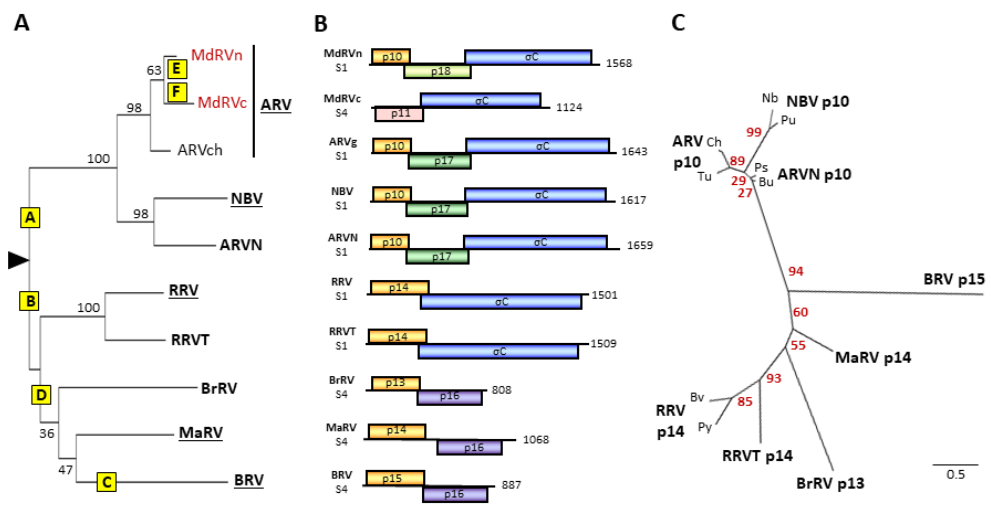
Figure 3. Phylogenetic analysis of fusogenic orthoreoviruses and FAST proteins and comparisons of their polycistronic genome segments. ( A ) Maximum likelihood unrooted phylogram of the sigma-class outer capsid clamp proteins of the eight fusogenic orthoreovirus species. The tree with the highest log likelihood is shown and included 10 amino acid sequences. See Supplementary Table S2 for a list of viruses, host species, and accession numbers The ARV species included single isolates from three subgroups, chickens (ARVch) and classical (MdRVc) and novel (MdRVn) MdRVs. Bootstrap values (500 replicates) indicating the percentage of trees in which the associated taxa clustered together are shown next to the branches. Branch lengths are to scale and measured by the number of substitutions per site. Yellow boxes labeled A–F indicate predicted genetic events leading to the extant species, as described in the text: A—recombinant gain of p10 FAST protein precursor; B—recombinant gain of p13/p14 precursor; C—potential recombinant gain of p15 precursor; D—recombinant gain of p16 and loss of fiber proteins; E—point mutations ablate p10 function; F—recombinant loss of p10 FAST protein. ( B ) Diagrams of the polycistronic S1 and S4 genome segments, drawn to approximate scale, of the indicated eight species or proposed species of fusogenic orthoreoviruses, plus the MdRVc (MdC) and MdRVn (MdN) subgroups of non-fusogenic ARVs from waterfowl. Open reading frames are depicted by rectangles, labeled to indicate the protein product and color-coded to depict functional or evolutionary protein relationships: yellow—FAST protein; blue—fiber protein; green—potential cell cycle inhibitory protein; purple—homologous proteins with no defined function; pink—heterologous nonfusogenic protein of no defined function. Numbers refer to mRNA length. ( C ) Maximum likelihood unrooted phylogram of the FAST proteins encoded by the indicated eight species or proposed species (boldface) of orthoreoviruses. The tree with the highest log likelihood is shown and included 14 amino acid sequences. See Supplementary Table S3 for a list of viruses, host species, and accession numbers. Lowercase labels denote isolates within a species: Ch and Tu are chicken and turkey isolates of ARV; Bu and Ps are bulbul and psittacine isolates of ARVN; Nb and Pu are the prototype NBV and Pulau isolates of NBV; Bv and Py are the bush viper and python isolates of RRV. Bootstrap values (500 replicates) indicating the percentage of trees in which the associated taxa clustered together are shown next to the branches. Branch lengths are to scale and measured by the number of substitutions per